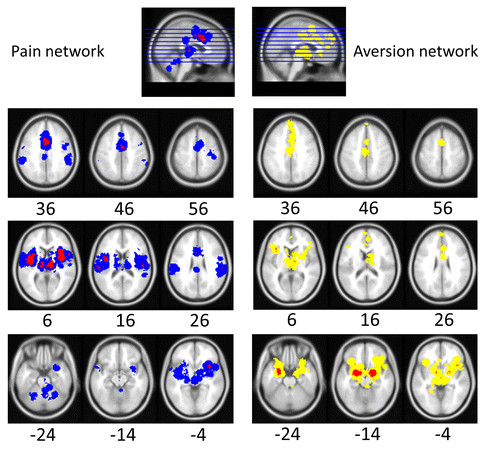
Pain and aversion networks in humans. Results of meta-analysis for human pain-related (left) and aversion-related (right) studies. Pain-related (left) activations (see Additional file 1: Table S1A for related coordinates): Red represents peak voxels in a local neighbourhood, blue represents significant extended clusters. Aversion-related (right) activations (see Additional file 1: Table S1B for related coordinates): Red represents peak voxels in a local neighbourhood, yellow represents significant extended clusters. All results are family-wise error rate whole-brain corrected at p < 0.05. Numbers below each axial section represent the Z coordinates. The anatomical reference space is MNI 152 (i.e. the average of 152 healthy MRI brain scans). The aversion network was previously reported by [5] and is reprinted here with permission from Frontiers in Integrative Neuroscience.